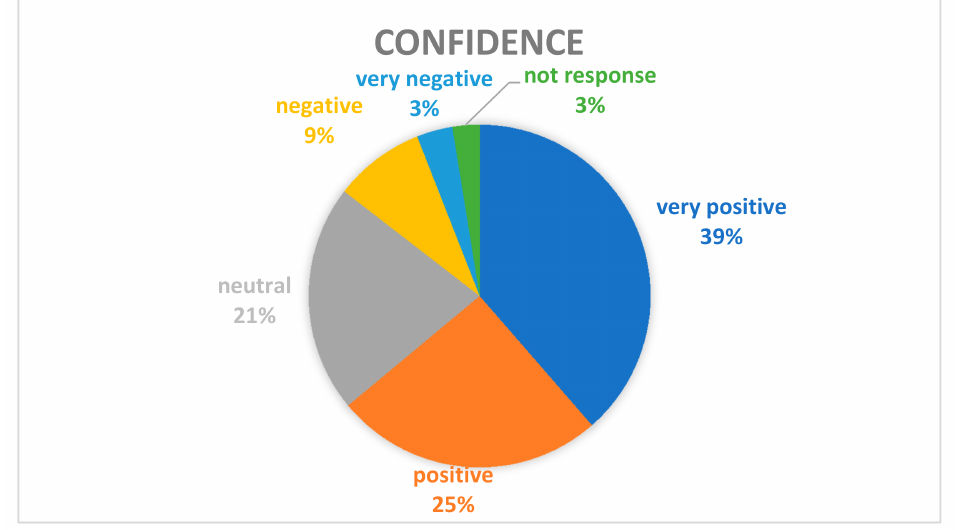
Figure 5. Graph of the average response to the questions of the trust